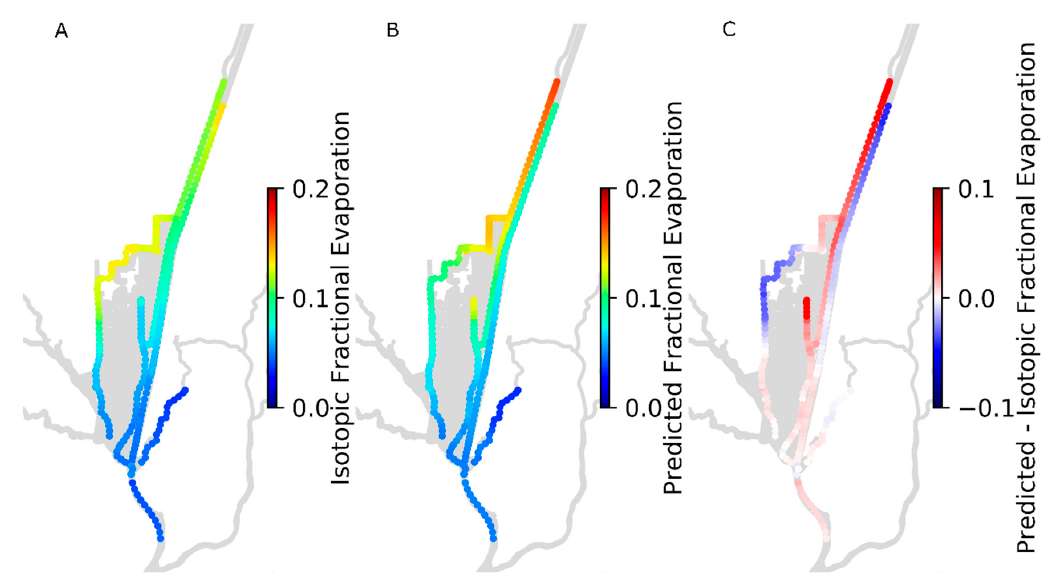
Figure 9. ( A ) Fractional evaporation estimated from stable isotope observations; ( B ) predicted fractional evaporation of Sacramento River water; ( C ) predicted minus isotopic fractional evaporation.